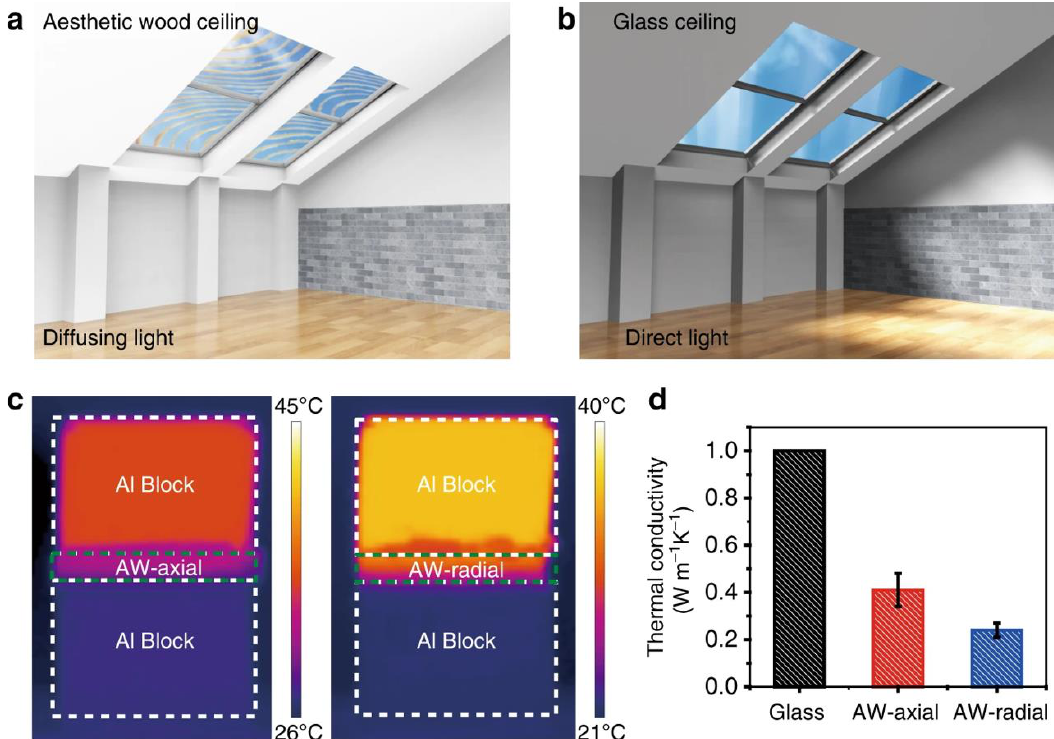
Figure 30. ( a , b ) The schematic shows the light distribution and aesthetic appeal inside a building when applying the aesthetic wood (abbreviated as AW in the ( d ) ceiling), compared with the glass ceiling. ( c ) IR images of aesthetic wood with temperature distributions in the axial (AW-axial heat transfer direction is parallel to the aligned wood microchannels) and radial (AW-radial heat transfer direction is perpendicular to the aligned wood microchannels) directions. ( d ) Thermal conductivities of glass [45], axial (AW-axial) and radial (AW-radial) direction of aesthetic wood. Error bars represent standard deviation. Reprinted from [44] under CC-BY license.